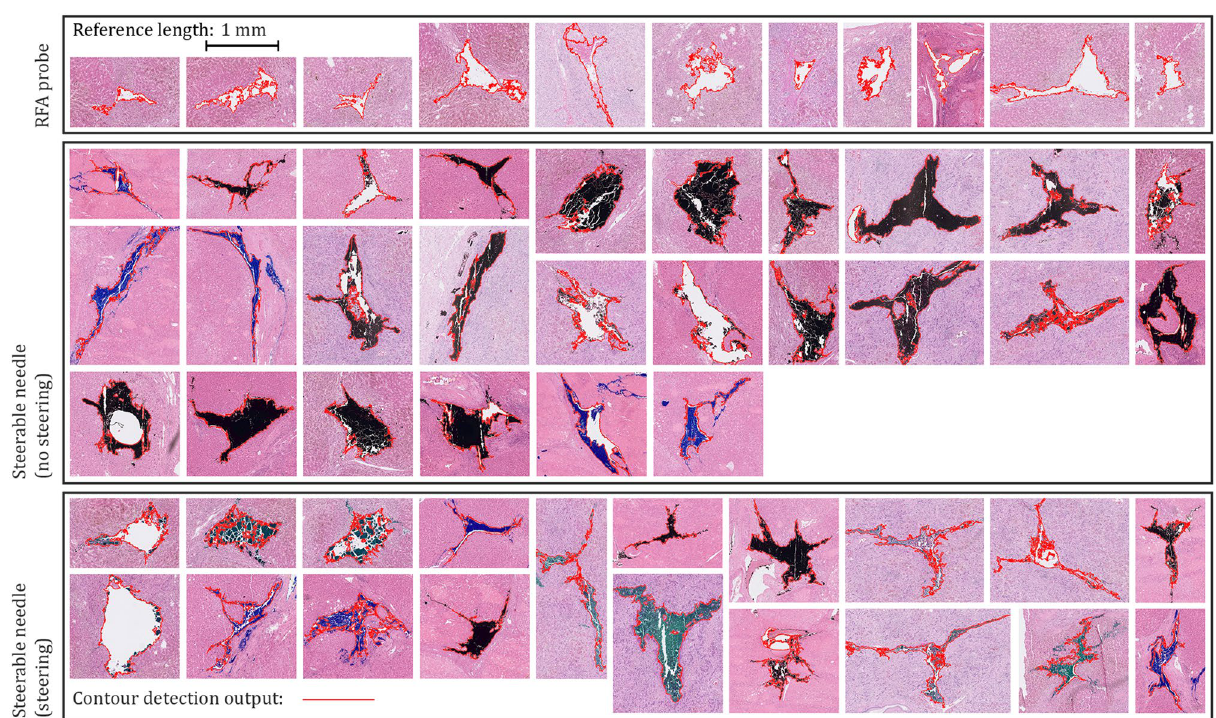
Figure 4. Close-ups of (inked) tissue damage sites in the histology slides. The results of a CCA-based automatic contouring step are shown as red